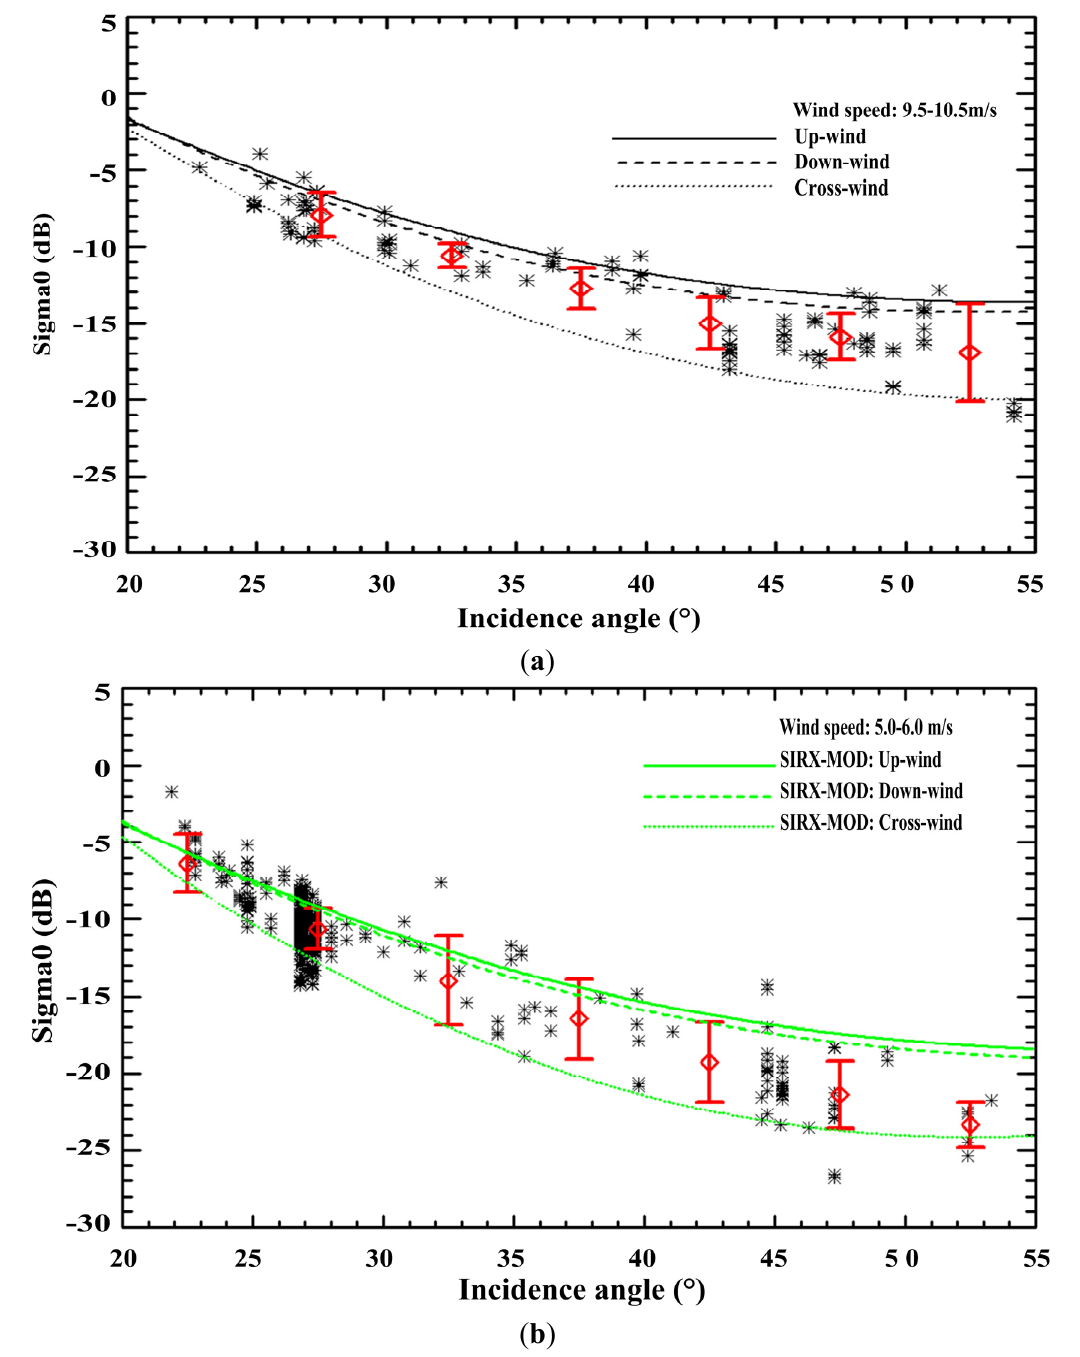
Figure 7. NRCS values simulated using the SIRX-MOD model for various incidence angles at sea surface wind speeds of ( a ) 10 m/s and ( b ) 5.5 m/s. The red error bars are plotted as the mean value ± standard deviation of the X-SAR